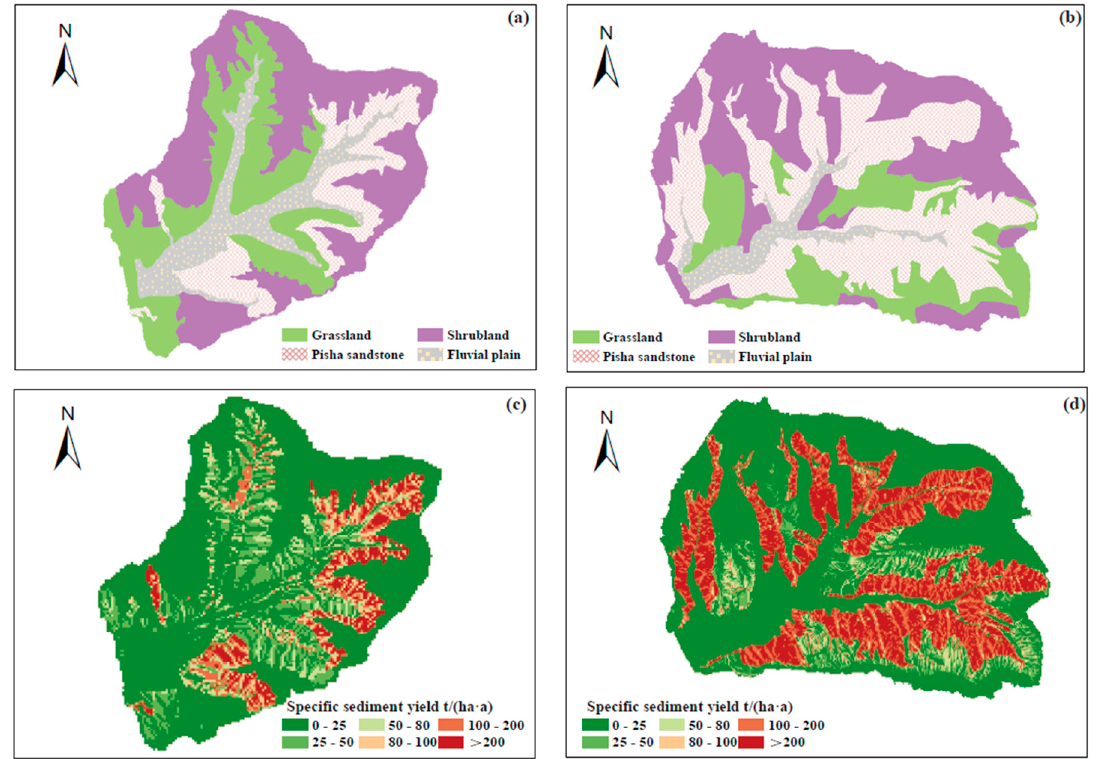
Figure 7. Land-use and specific sediment yield of two dam-controlled watersheds: watershed 8 ( a , c ); watershed 21 ( b , d ).